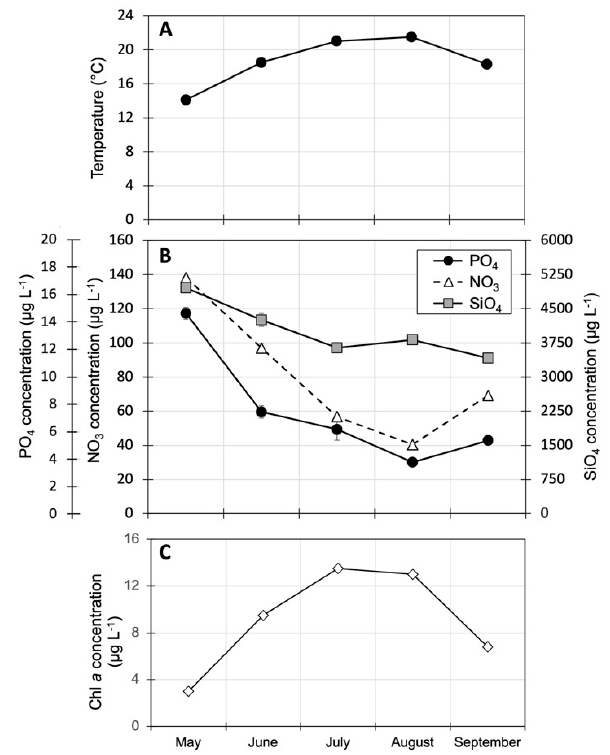
Figure 1. Monthly mean values of surface temperature ( A ), nutrient concentrations ( B ) and chl a concentrations ( C ) measured in the Columbia River from the sampling site near Vancouver, WA, from May to September 2018. Error bars are 1 SE (most too small to be